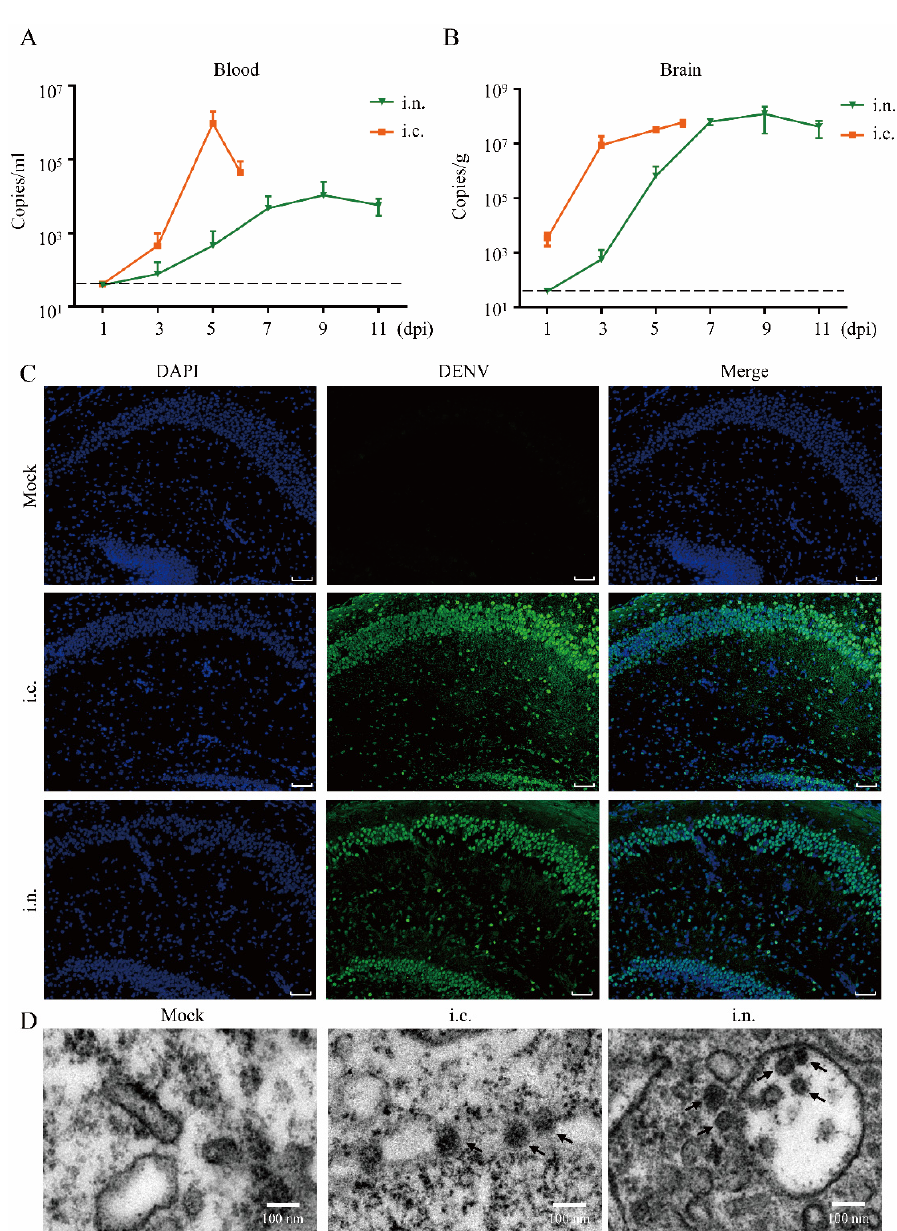
Figure 2. Infection status of DENV-2 challenged suckling mice. ( A ) Blood samples were harvested, and viremia was evaluated (each time point, n = 4 or n = 5). The dotted black line indicates the limits of detection. ( B ) Brain samples were harvested, and the virus titer was evaluated using RT-PCR (each time point, n = 4 or n = 5). ( C ) Immunostaining of the hippocampal CA1 and CA2 area from intracranially and intranasally challenged mice at the severe illness phase (5 and 9 dpi, respectively). Scale bar: 50 µ m. ( D ) Representative transmission electron micrographs showing viral particles in DENV-2 challenged suckling mouse brains. Black arrows, viral particles.